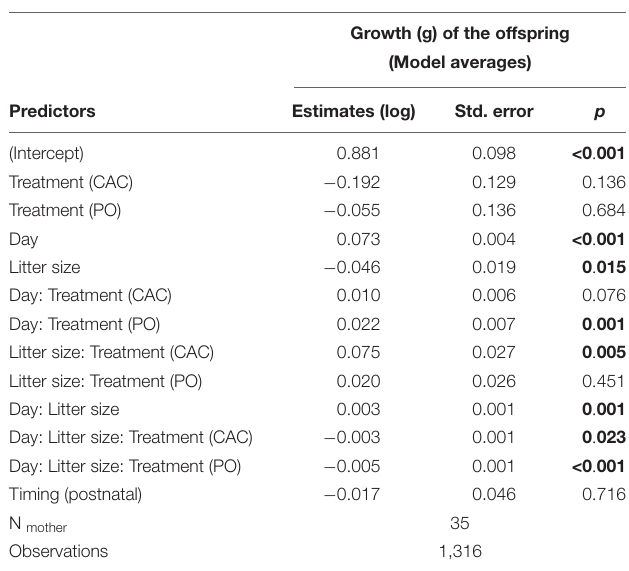
TABLE 2 | Model summary of the offspring